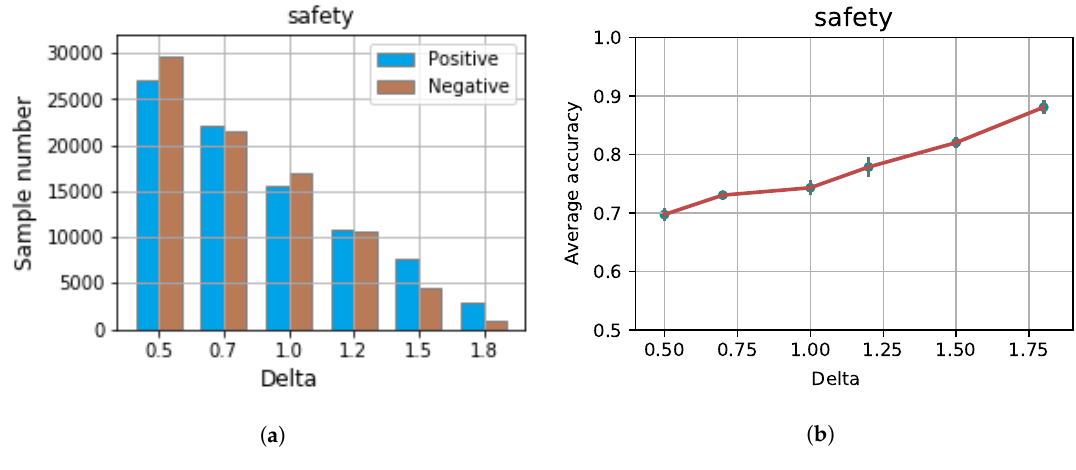
Figure 5. Sample number ( a ) and the average accuracy ( b ) in the experiment. The vertical bars in the left figure show the positive and negative samples used in the training task with different threshold values. The red curves in the right figure indicate the average accuracy with different training sample